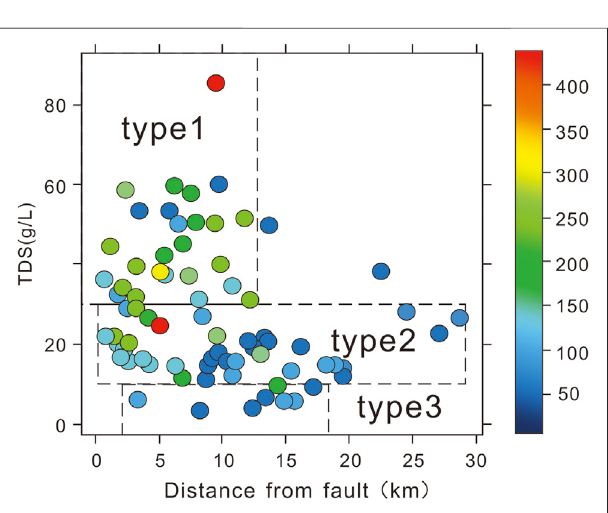
FIGURE 5 | Intersection of formation water salinity value, Na/K value, and distance from the fault in the Middle Jurassic Shaximiao Formation in the Zhongjiang gas fi